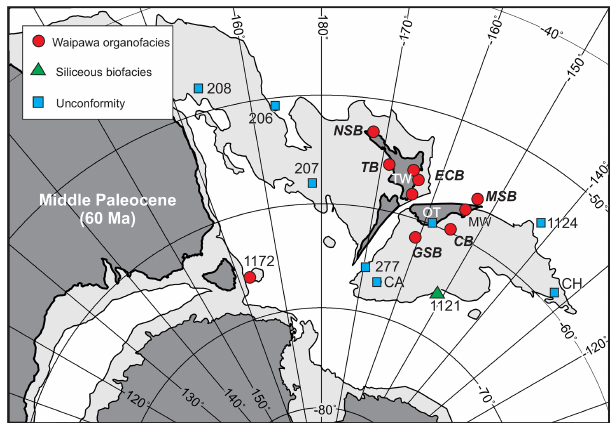
Figure 2. Localities where Waipawa organofacies is present or rep- resented by an unconformity or a correlated siliceous biofacies on a middle-Paleocene paleogeographic reconstruction (from Hollis et al., 2014). Locality abbreviations: NSB, North Slope Basin; TB, Taranaki Basin; TW, Taylor White section; ECB, East Coast Basin; MSB, Marlborough Sub-basin; MW, mid-Waipara section; CB, Canterbury Basin; OT, onshore Otago; GSB, Great South Basin; CH, Chatham Island; CA, Campbell Island. Numbers refer to DSDP or ODP sites. See Fig. S1 for present-day section